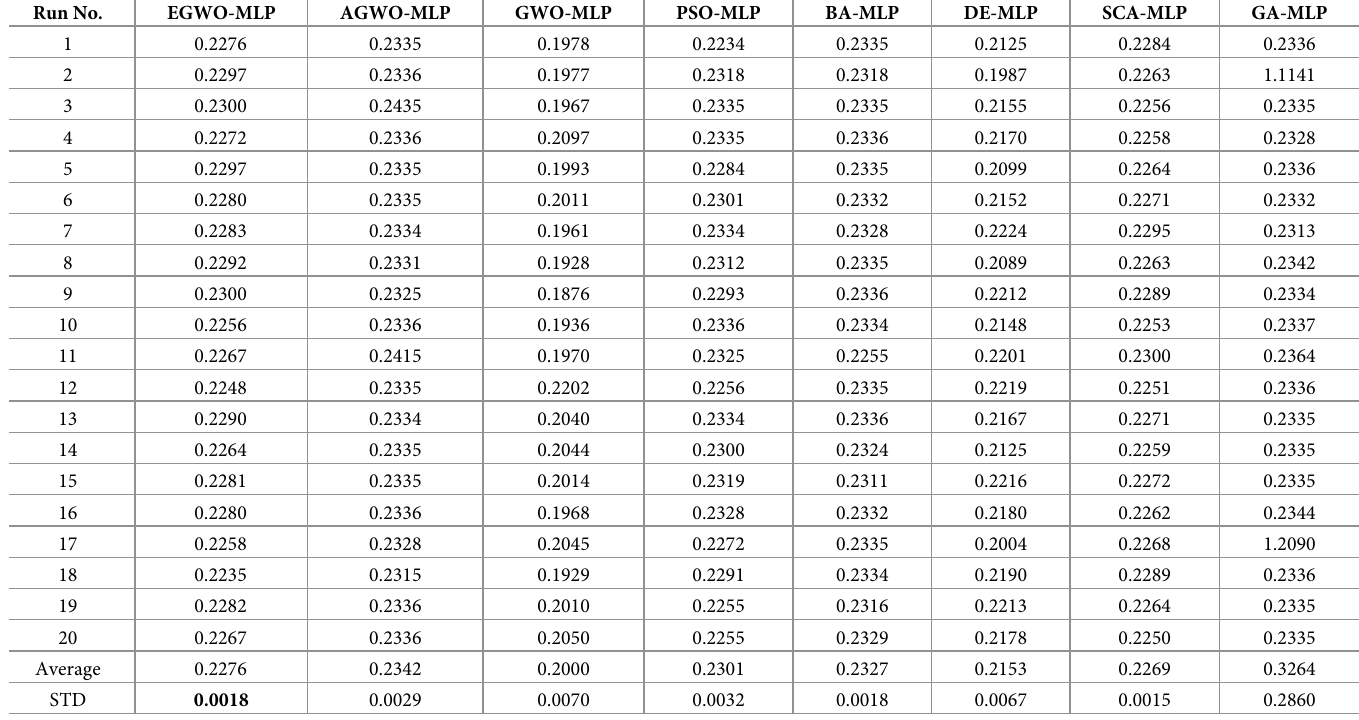
Table 3. The training error of the Mathematics (Mat.) subject achievement